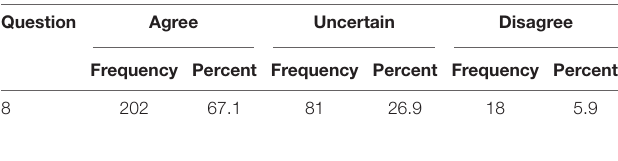
TABLE 10 | Frequency and percent of the questions related to the learners’ learning styles in technology integration learning